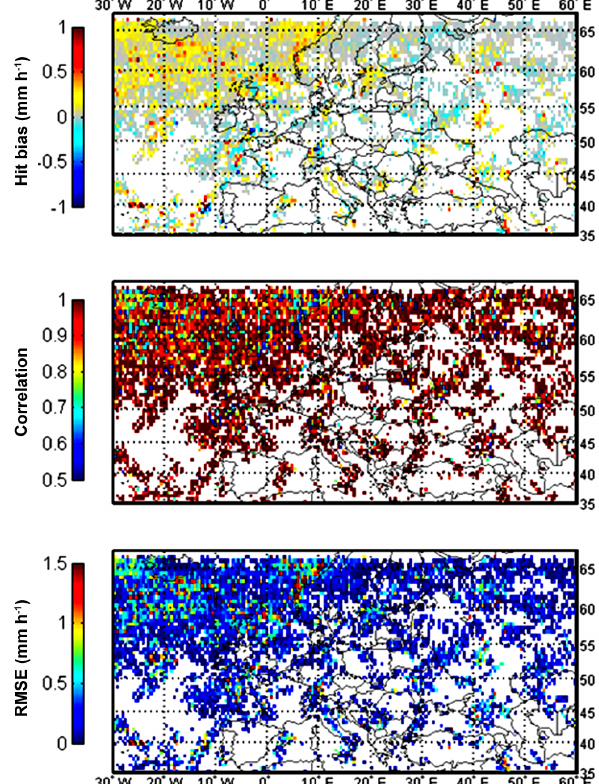
Figure 7. Hit bias (top panel), CC (middle panel), and RMSE (bot- tom panel) resulting from the comparison between PNPR v2 re- trievals and GPM-KuPR measurements over the European area (us- ing a 0.5 ◦ × 0.5 ◦ regular grid, for the period 1 March 2014–31 May